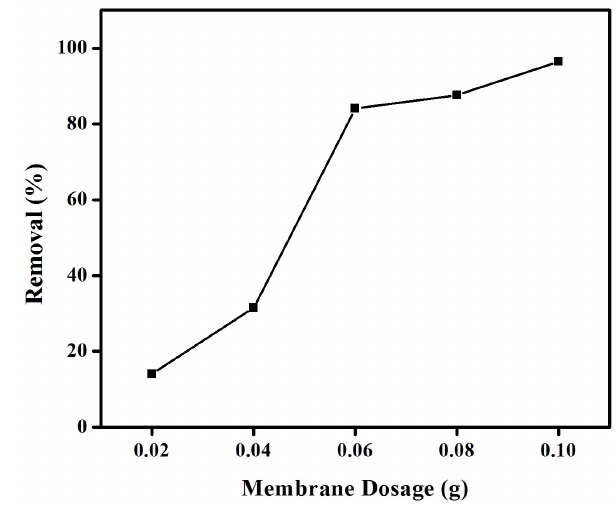
Figure 3. Effect of membrane dosage on the removal (%) of congo red using an anion exchange membrane